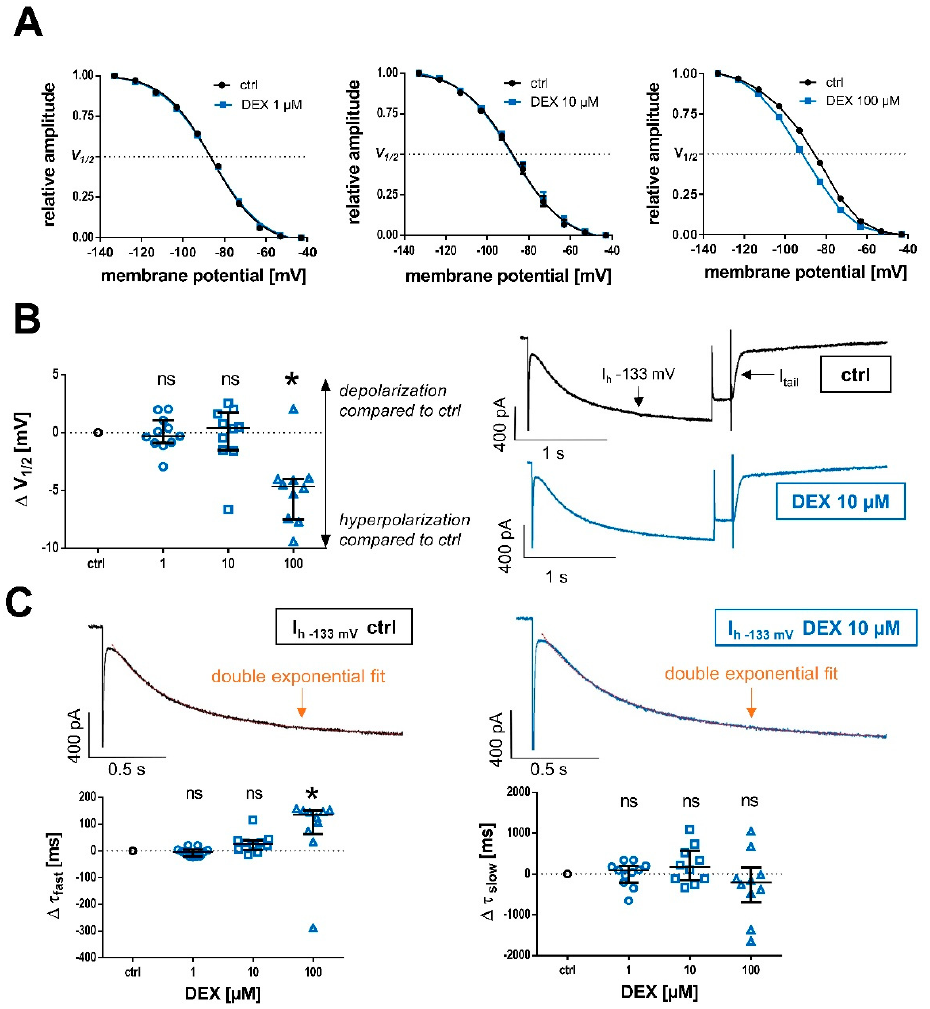
Figure 3. ( A ) In order to analyze voltage-dependent channel gating and steady-state activation curves of HCN channels under control conditions and after the application of increasing DEX con- centrations, normalized tail current amplitudes (I tail ) were fitted to a curve using the Boltzmann function. The tail step was set at − 103 mV for each voltage step before returning to − 43 mV. V 1/2 : half-maximal activation voltage. ( B ) Only the high concentration of 100 µM DEX led to a significant left shift (toward hyperpolarization) in V 1/2 compared to the control ( − 86.6 [ − 85.2– − 88.0] mV). Re- spective current traces under control conditions and after the application of 10 µM DEX are depicted on the right. Tail currents (I tail ) were measured subsequent to the hyperpolarizing voltage step at the fixed “tail” step of − 103 mV before returning to − 43 mV. Δ : absolute change compared to control. Ns: not significant. * p < 0.05. ( C ) Representative current traces of I h at the hyperpolarizing voltage step of − 133 mV under control conditions and after 45 min of DEX application (10 µM) are depicted above. By fitting a biexponential function to I h (as indicated by the dotted line), fast ( τ fast ), and slow ( τ slow ) time constants of time-dependent activation were determined. Only the high concentration of 100 µM DEX resulted in a significant deceleration of the fast activation constant compared to the control (231 [214–273] ms), presented as absolute changes. The slow time constant was not affected (control: 1143 [986–1405] ms). 2.3. Effects of DEX on TC Neuron Firing Properties Lastly, we evaluated whether DEX affects modalities of neuronal excitability in TC relay neurons generally associated with HCN channel function. Therefore, we performed additional whole-cell current-clamp recordings. Upon injection of a hyperpolarizing cur- rent ( − 350 pA, 500 ms), TC neurons display an anomalous rectification of the membrane